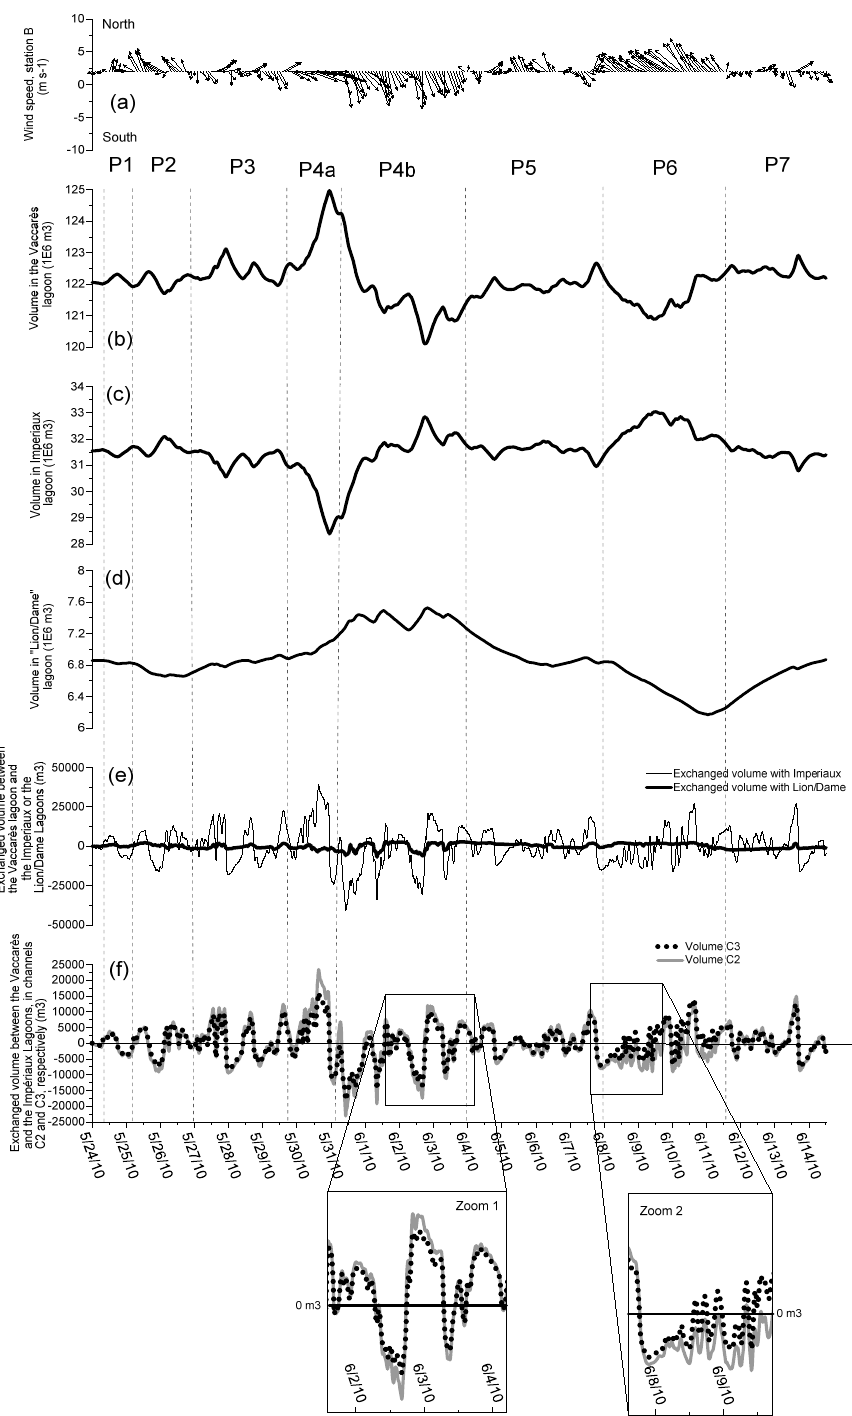
Figure 10. Measured wind vectors at the meteorological stations B ( a ); and total volumes in the Vaccarès lagoon ( b ); the Impériaux lagoon ( c ); and the complex Lion/Dame lagoon ( d ); Exchanged volumes between the Vaccarès lagoon and the Impériaux or the Lion/Dame lagoons are represented in ( e ) (a positive volume means an influx of water into the Vaccarès lagoon). Exchanged volumes in channels C2 and C3 (see Figure 3) are represented in ( f ) (a positive volume means a transfer of water from the Impériaux into the Vaccarès lagoon). Wind vectors at the meteorological station A are not represented, for the sake of legibility of the